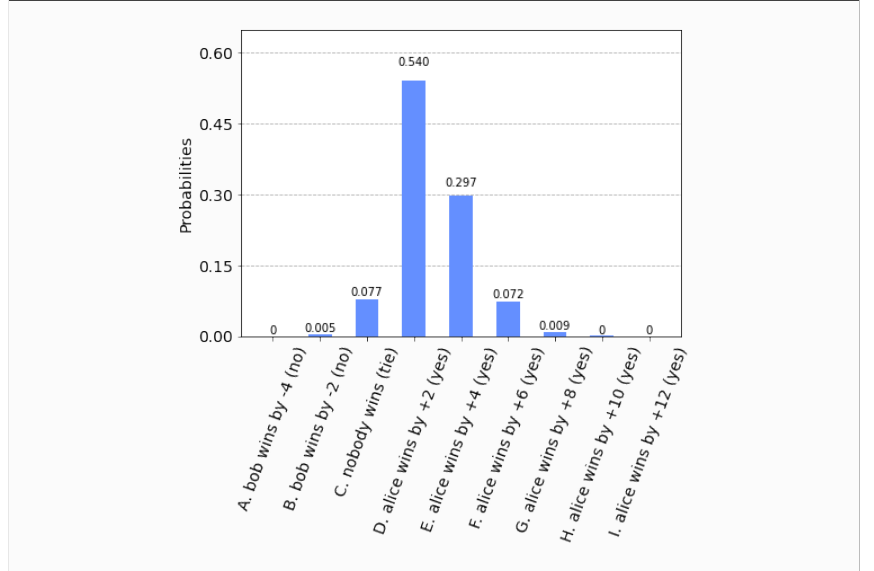
Figure 10. The possible outcomes and their probabilities when r A = 0.25 and r B = 0.50.